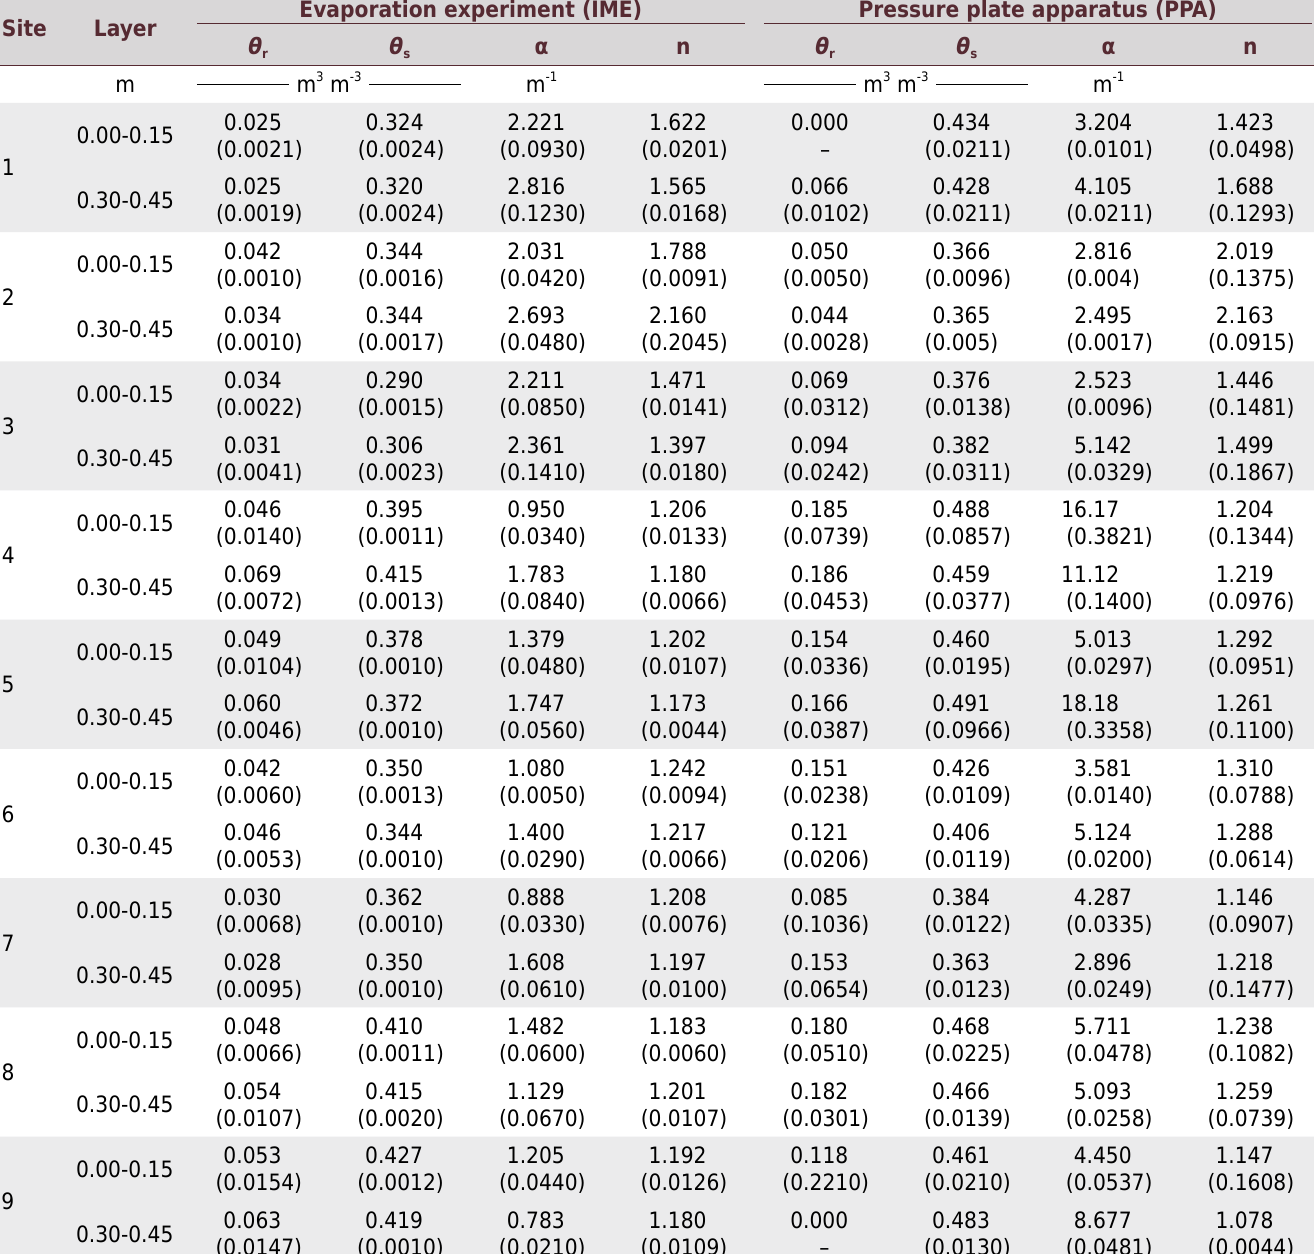
Table 2. Optimized van Genuchten parameters for water retention obtained by inverse solution using the evaporation experiment data and by fitting the pressure plate apparatus data. The values between parentheses are the standard errors representative of the five